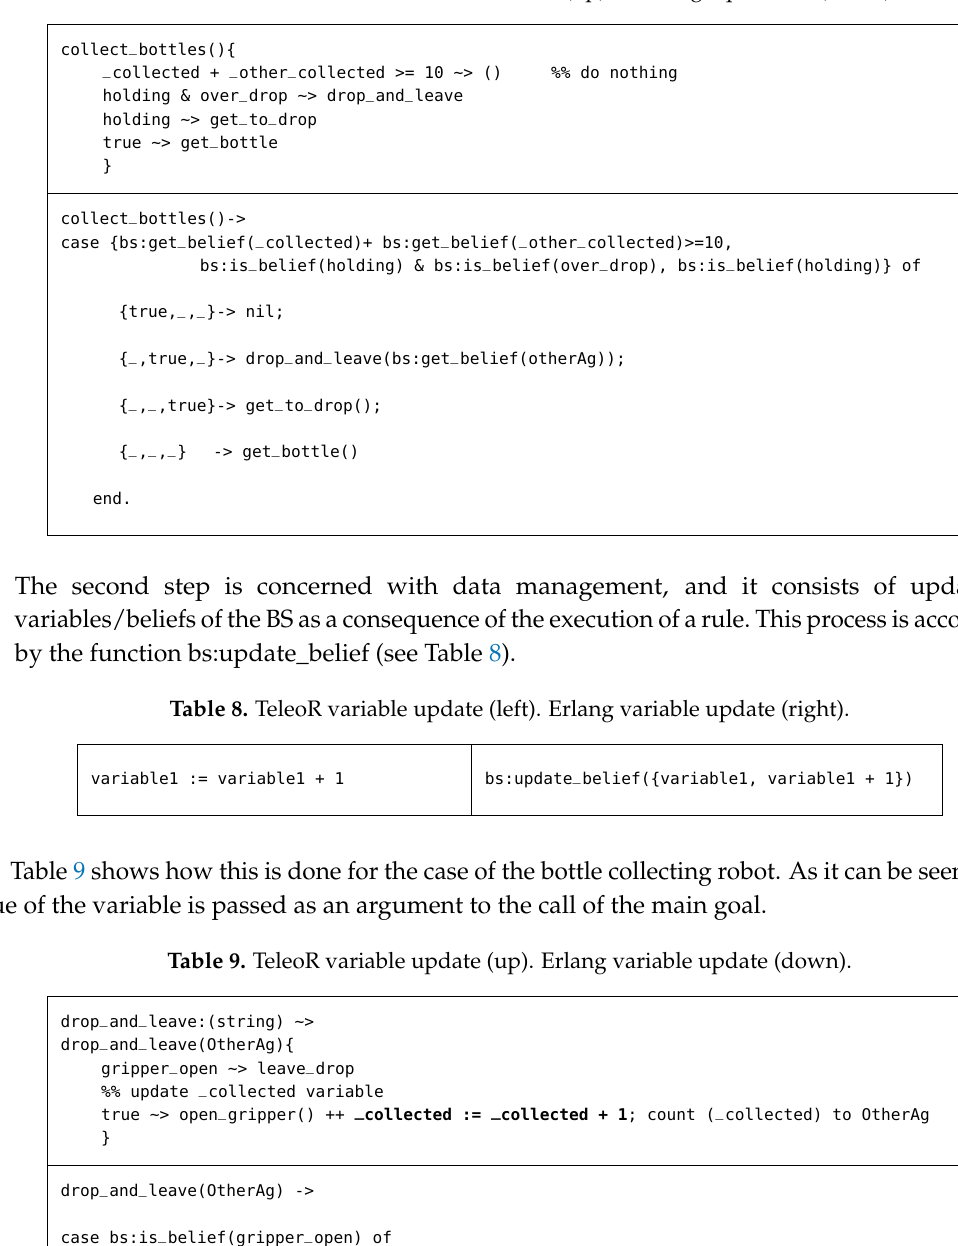
Table 7. From TeleoR condition on variables (up) to Erlang equivalent (down).